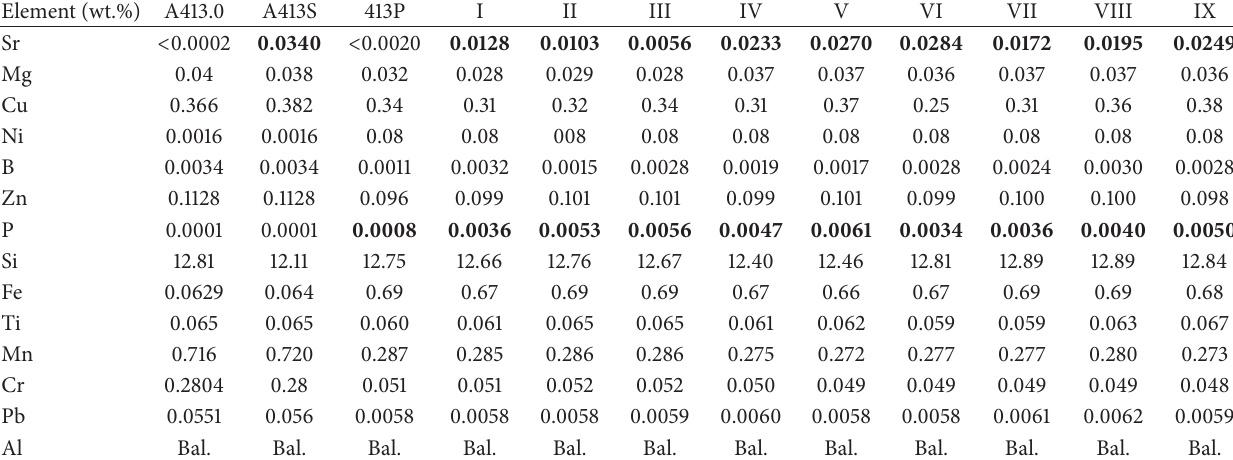
Table 2: Chemical compositions of A413 alloys containing Sr and